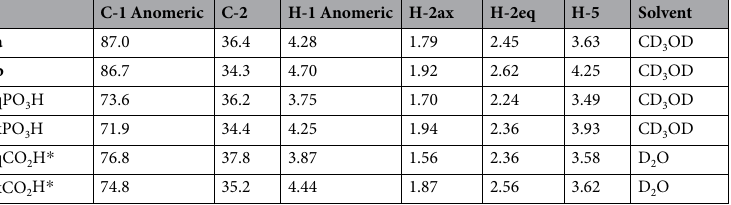
Table 2. Diagnostic 13 C and 1 H chemical shifts (ppm) of sulfo-sialic acid analogues compared to the corresponding phosphonic acids 4 , and carboxylic acids 20 . * Sialic acid numbering has been changed to assign the anomeric position as 1.